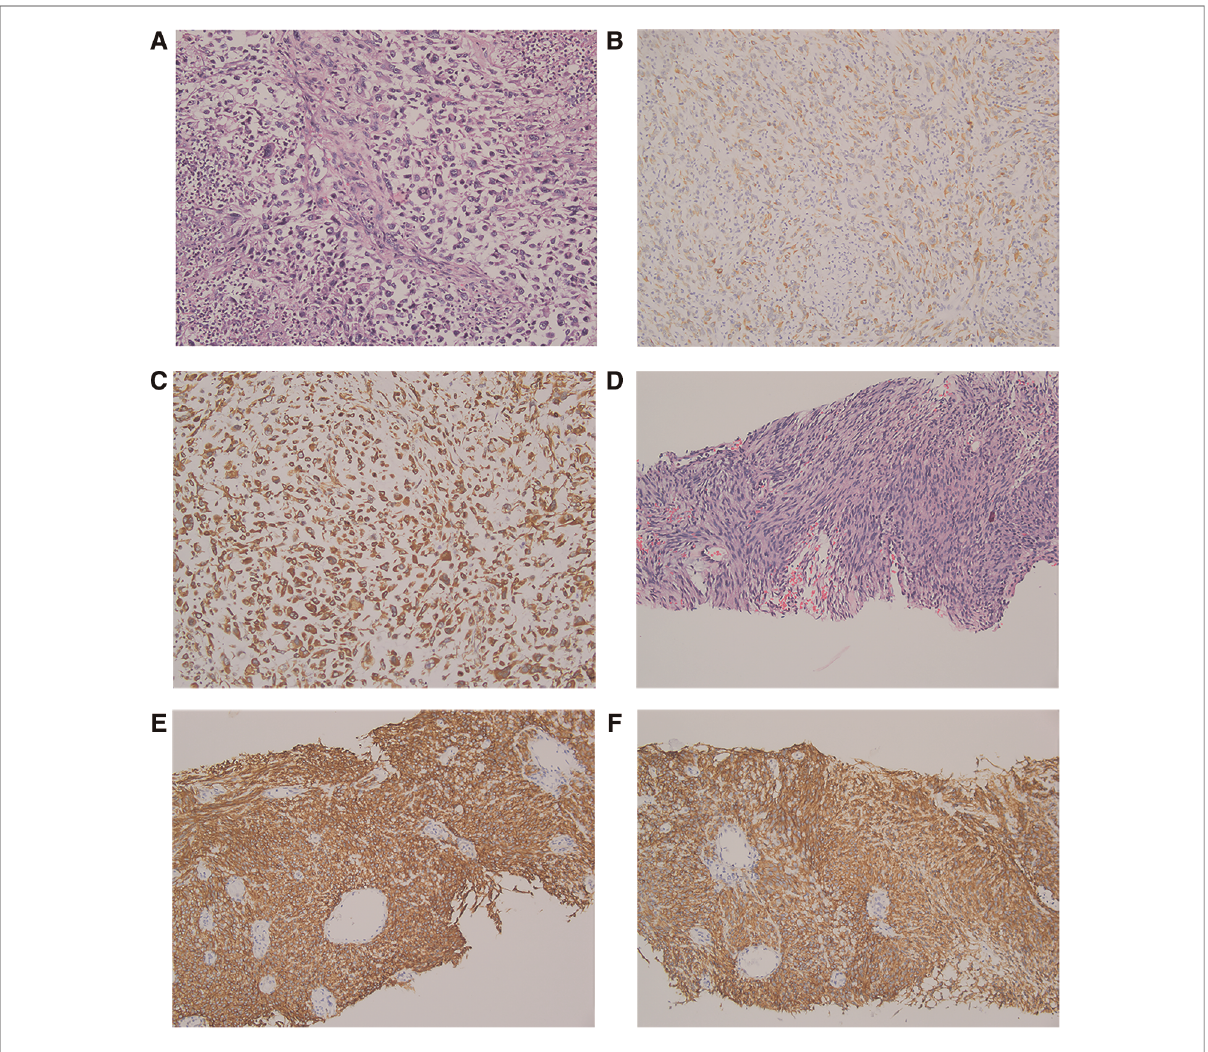
FIGURE 2 Pathology and immunohistochemistry of hepatic sarcomatoid carcinoma and gastrointestinal stromal tumors. Hematoxylin and eosin (H & E) staining of hepatic sarcomatoid carcinoma ( A ); the results of immunohistochemical staining of hepatic sarcomatoid carcinoma show CK positive ×200 ( B ) and AE1/AE3(+) positive ×200 ( C ); H&E staining of gastrointestinal stromal tumor ( D ); the results of immunohistochemical staining of the gastrointestinal stromal tumor shows CD117 positive ×200 ( E ) and DOG-1 positive ×200 ( F